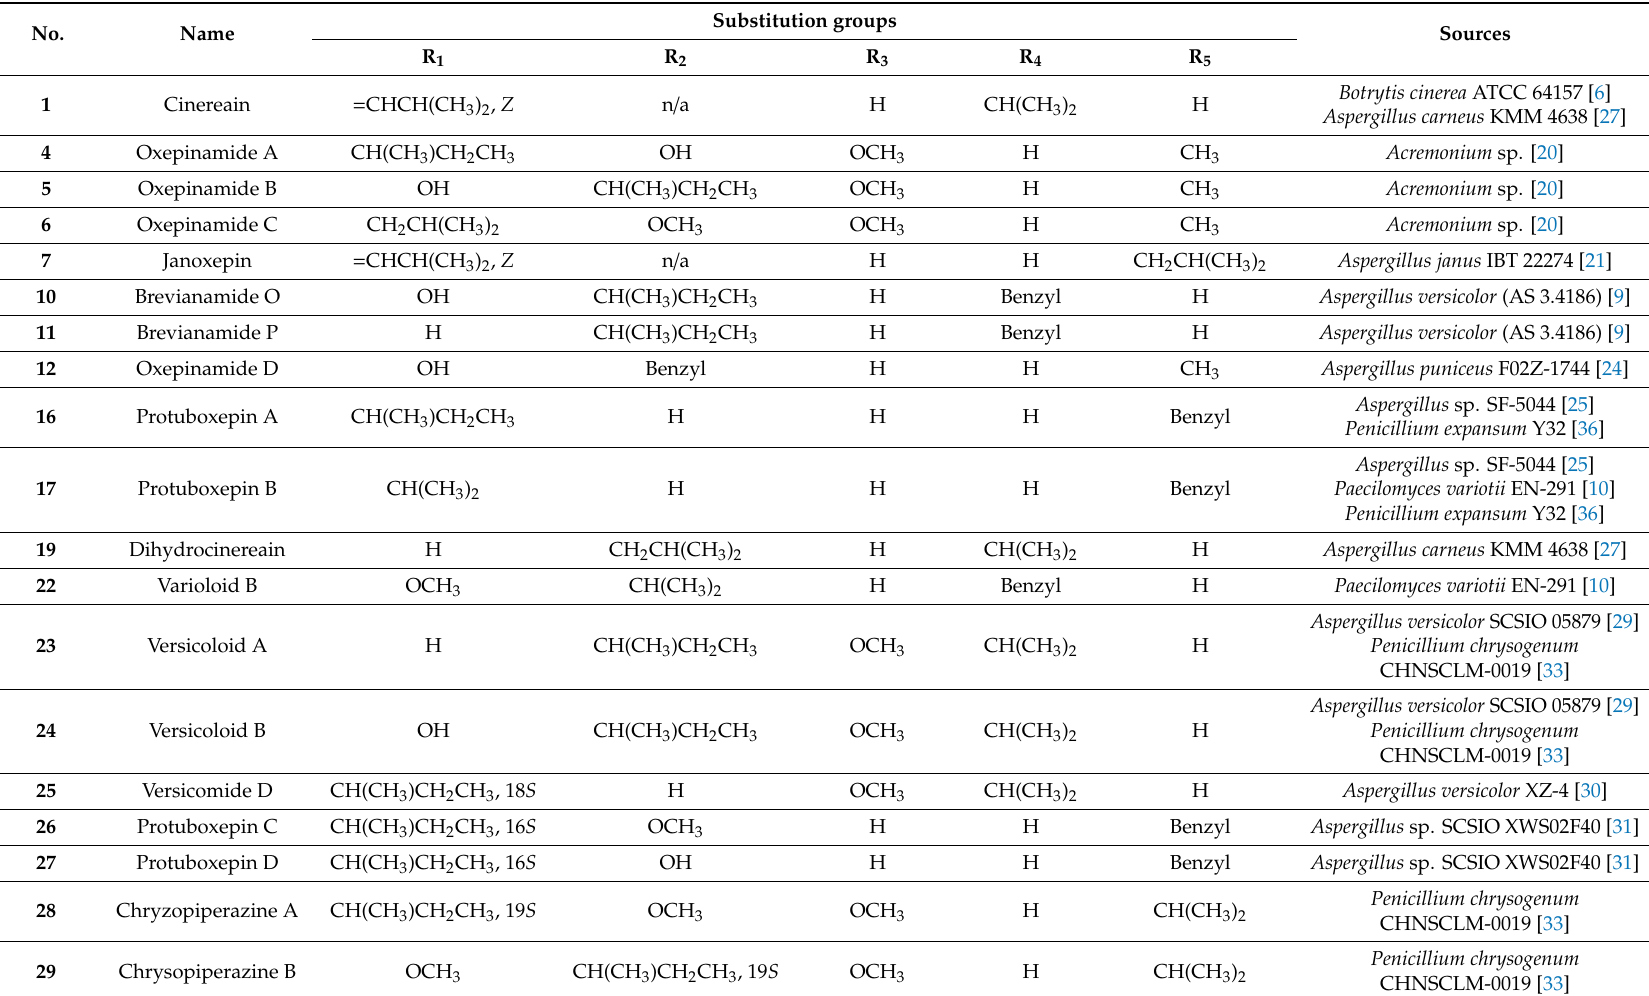
Table 1. Structures and Biological sources of Type A Oxepine-Pyrimidinone-Ketopiperazine